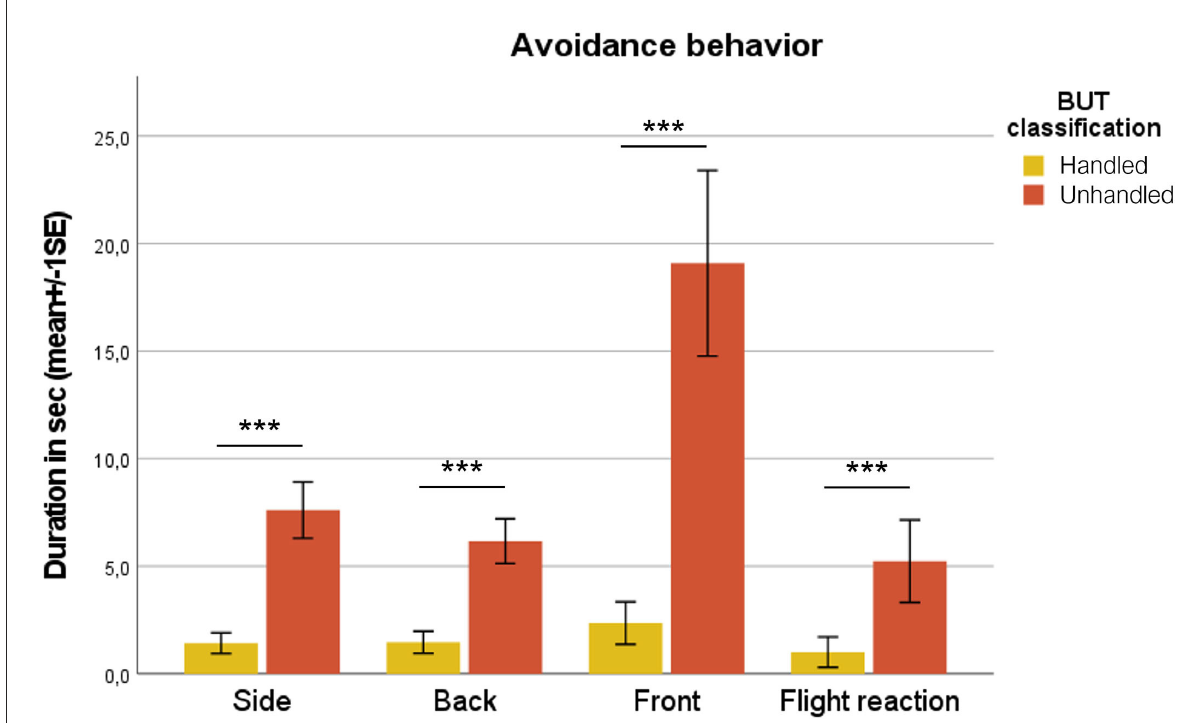
FIGURE2 Mean duration in seconds (1 SE) referred to avoidance behaviors in broken and unbroken group. Mann–Whitney test; *** p < 0.01.